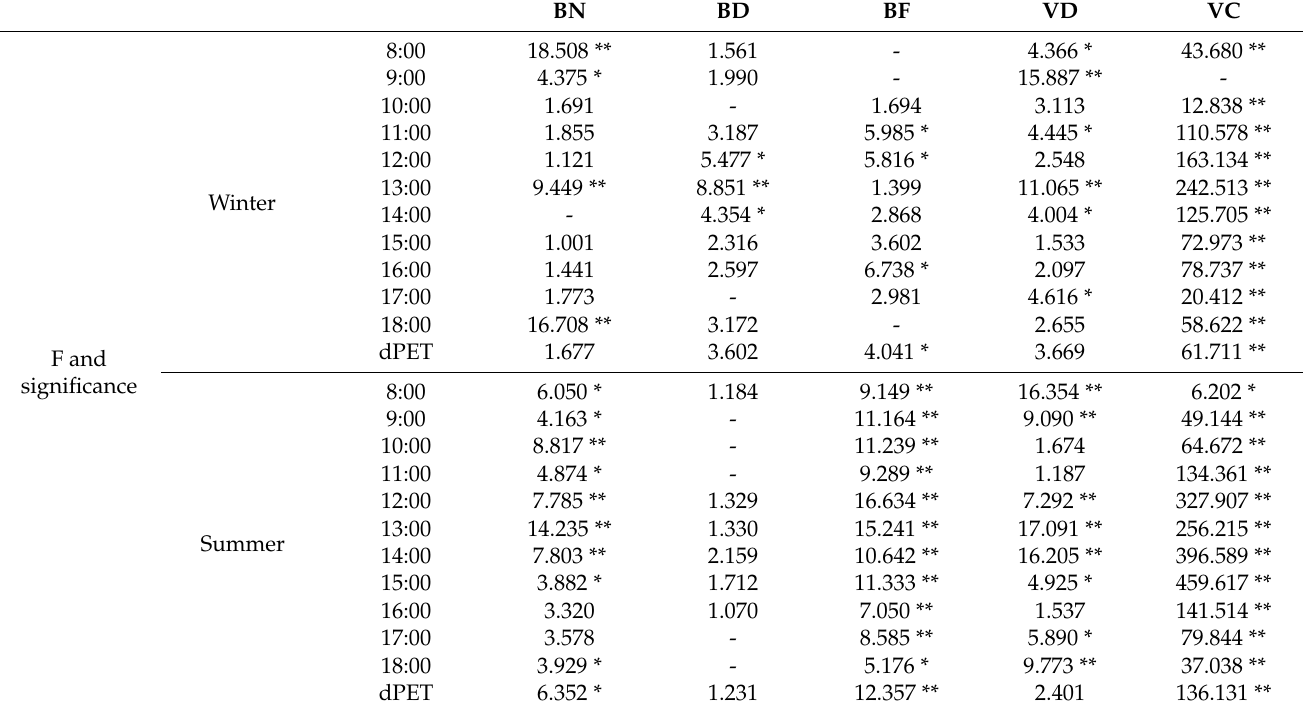
Table 6. Results of ANOVA on PET in winter and summer. BN BD BF